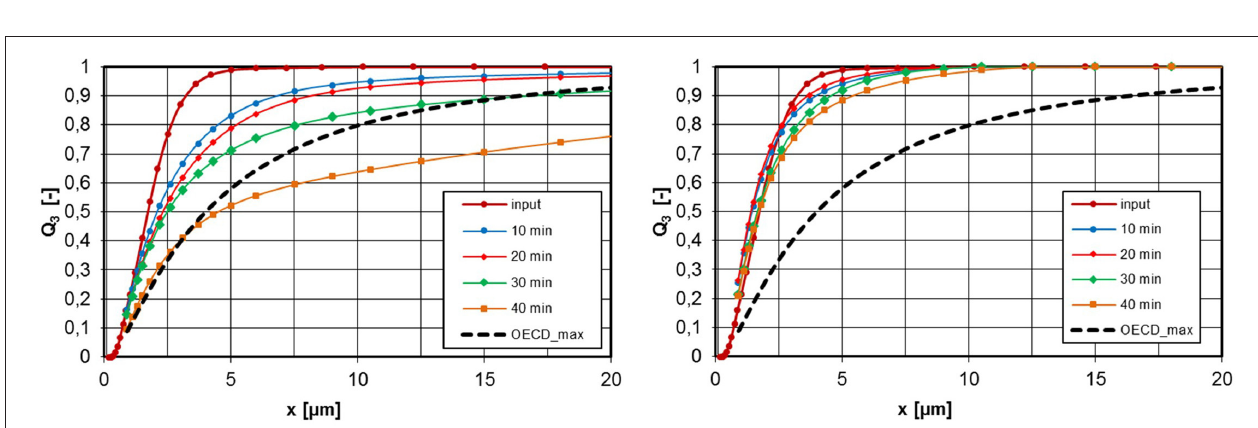
FIGURE 10 | PSD at the inlet and exhaust tube of the inhalation chamber for different operating times, calcium carbonate, ρ eff = 1,000 kg/m 3 , left: c m = 6,300 mg/m 3 , right: 500 mg/m 3 .